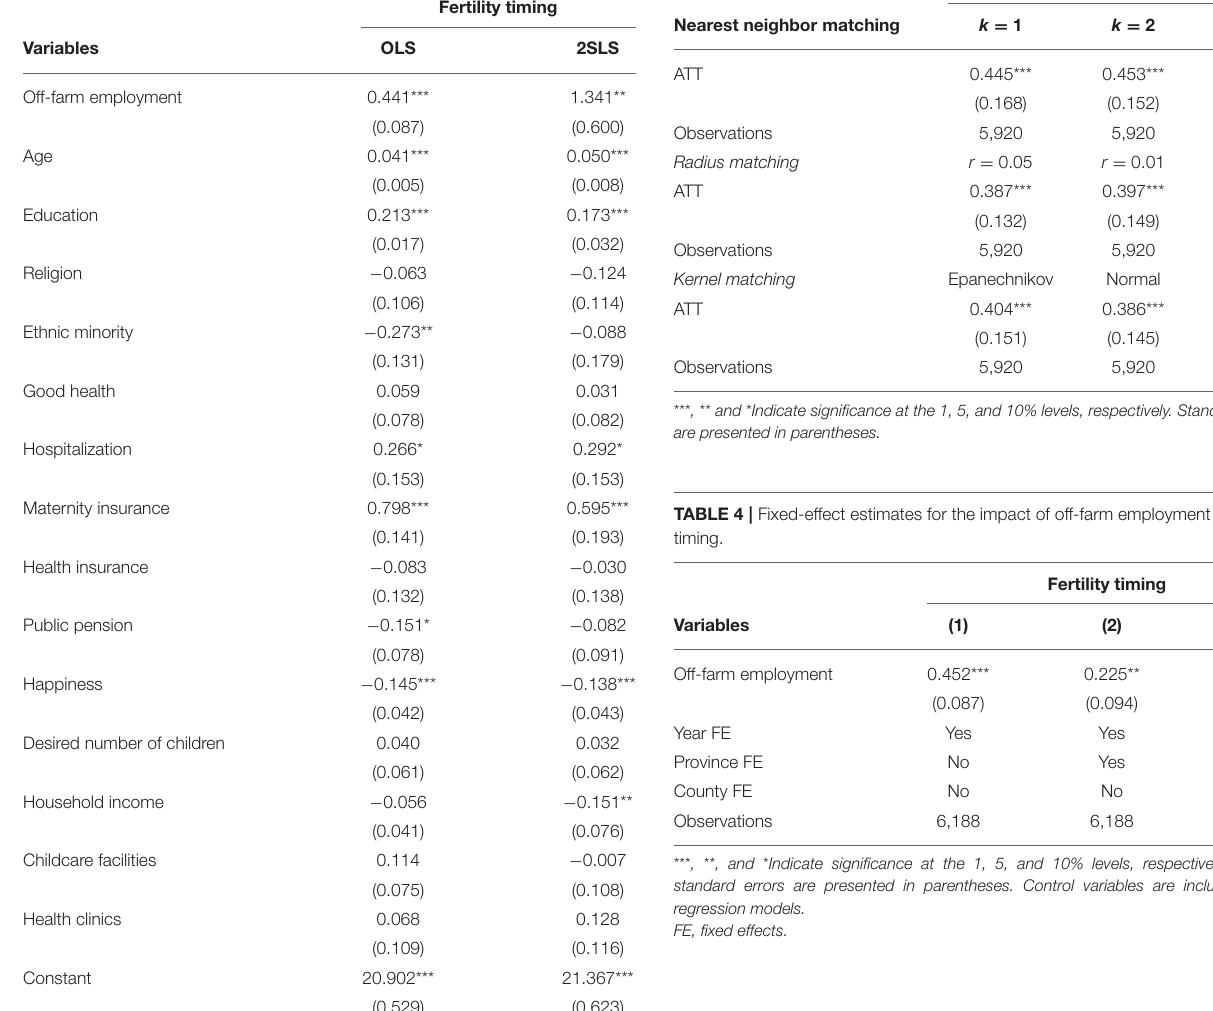
TABLE 3 | PSM estimates for the effects of off-farm employment on fertility timing.